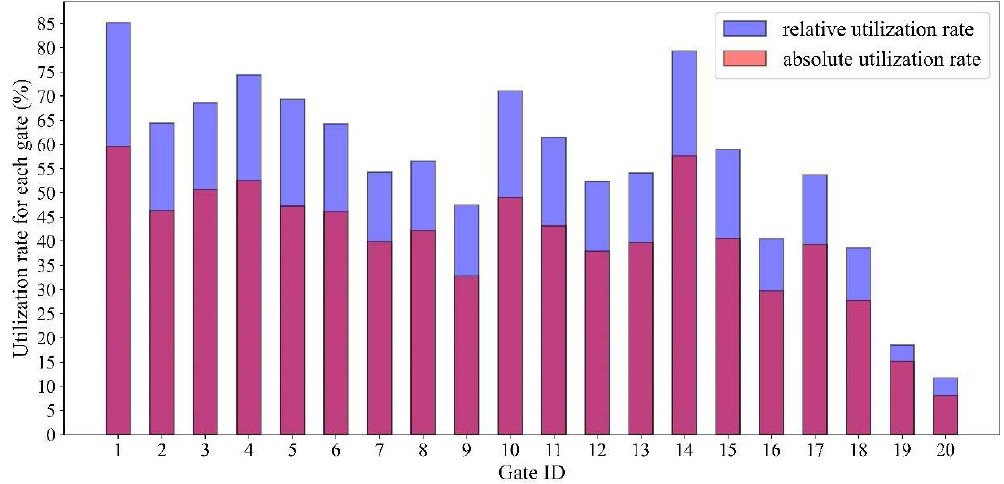
Figure 7. Utilization rate for each gate.